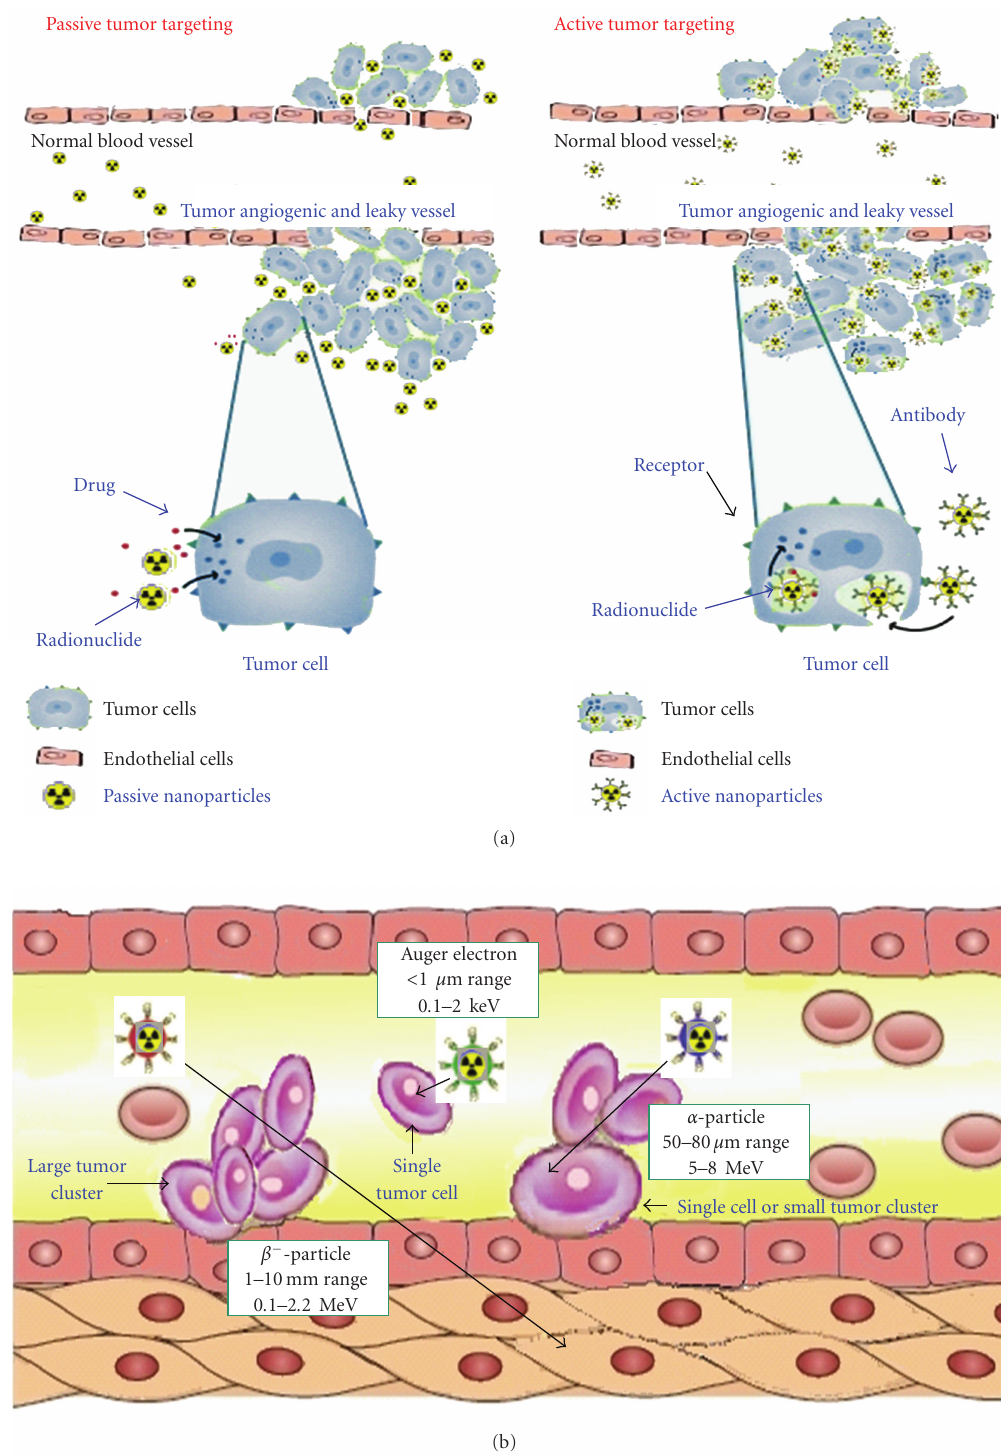
Figure 1: (a) Schematic illustration showing the possible mechanism for radionuclides or drug accumulation delivery system of nanoparticles by site specific passive tumor targeting using the enhanced permeability and retention (EPR) e ff ect or molecular a ffi nity and site specific active tumor targeting through ligand tumor cell surface receptors interaction, internalization, and intracellular action for tumor diagnostics and therapy (reproduced with modification with permission from [7]). (b) Schematic diagram of tumor tissue penetration range of internal radiotherapy by auger electron (0.1–2keV, < 1 μ m )-, α (5–8 MeV, 50–80 μ m range)-, and β (0.1–2.2 MeV, 1–10mm range )- radiation emitters for passively and actively nanotargeted radionuclide therapy (reproduced with modification with permission from